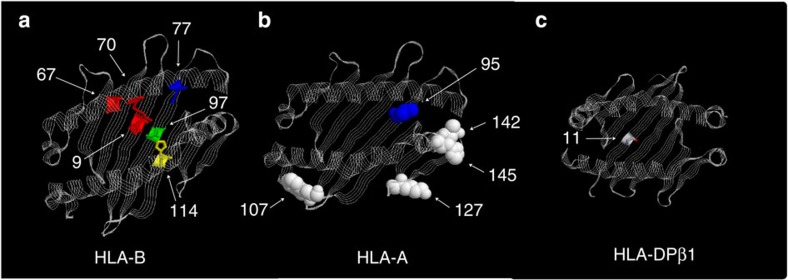
Three-dimensional models for the HLA-B, HLA-A and HLA-DPβ1 proteins.Three-dimensional models for the (a) HLA-B, (b) HLA-A and (c) HLA-DPB1 proteins. These structures are based on Protein Data Bank entries 3LV3, 3UTQ and 3LQZ, respectively, with a direct view to the peptide-binding groove.